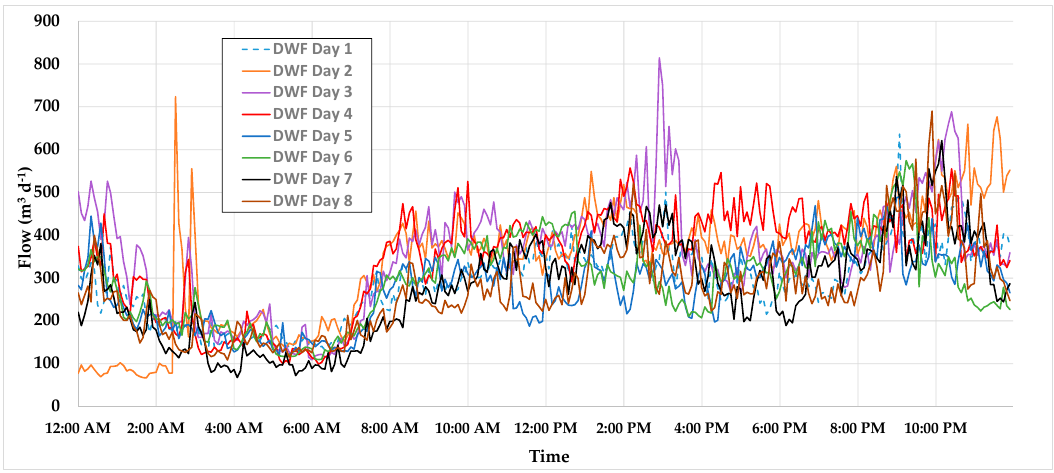
Figure 1. Hydrographs for all eight DWF days. 105